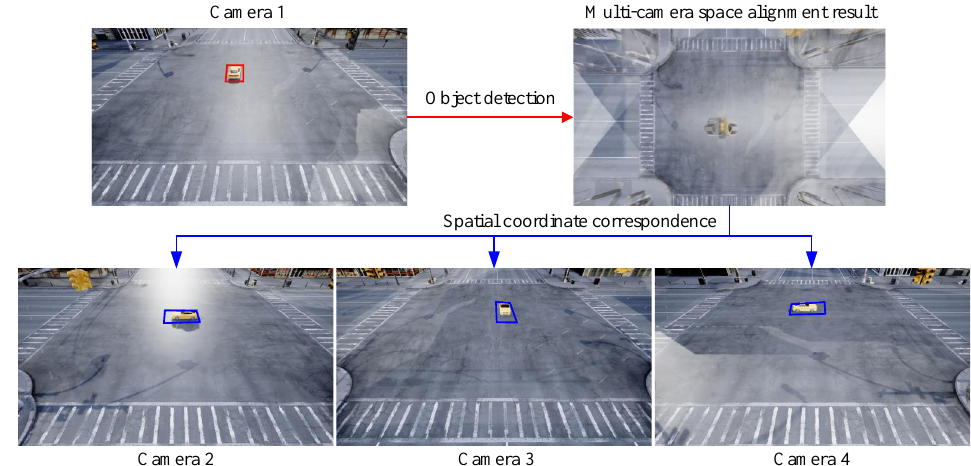
Figure 11. An applicable example of the proposed multi-camera space alignment approach. Our method aligns the four ground monitoring locations into one coordinate system. With this corre- sponding spatial relationship, the object information of the car in Camera 1 (marked in red) can be directly associated with its data in other related cameras (marked in